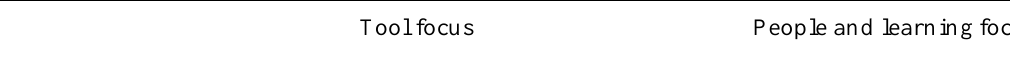
Table 4 Categories of Social Technology Use in